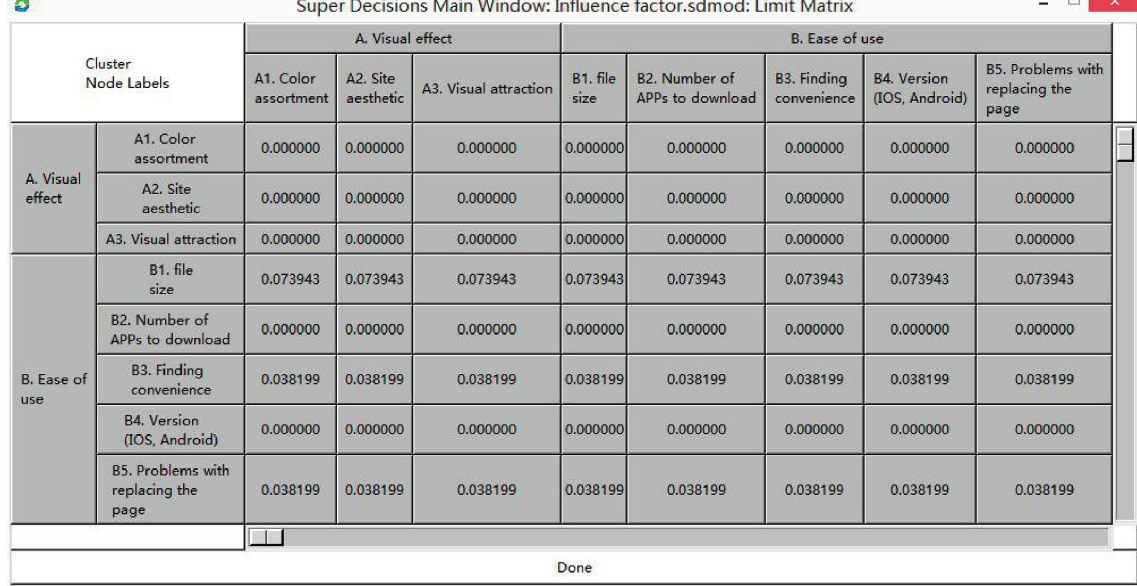
Figure 7: Implementation of the limit